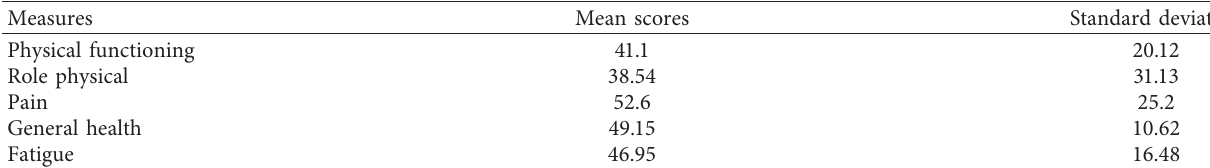
Table 3: Mean of the score of the measures of physical quality of life.